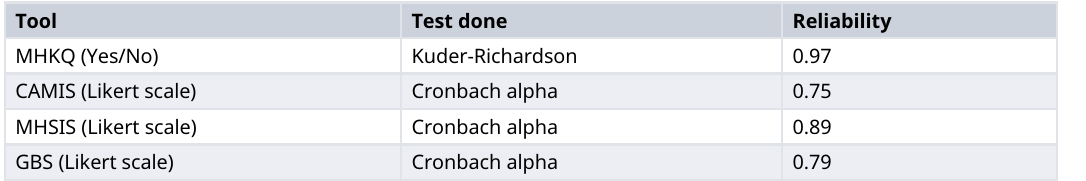
Table 2. Reliability testing of the study